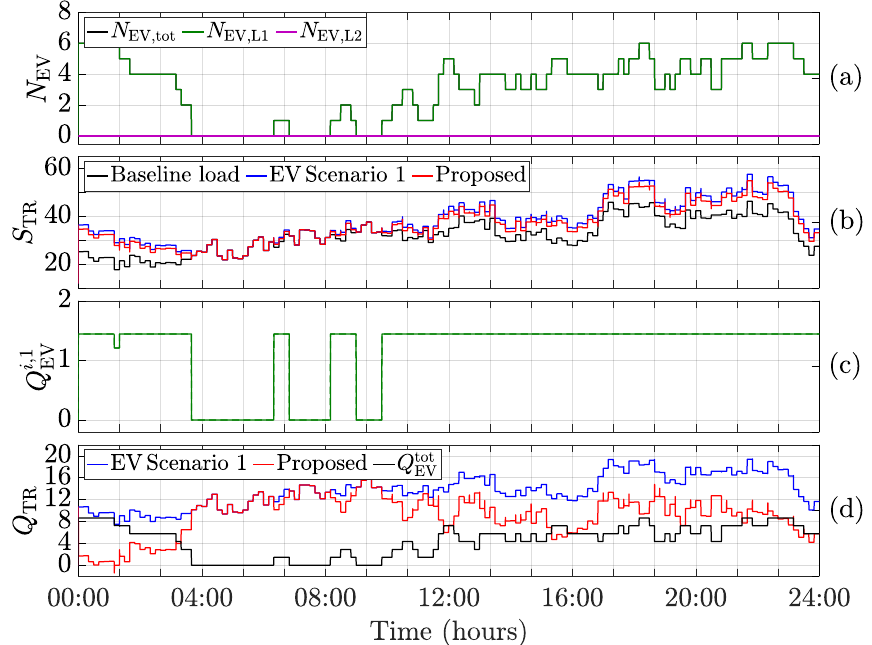
Figure 7. Scenario 1: EV charging at Level 1, ( a ) number of EVs present; ( b ) transformer apparent power in kVA; ( c ) Q supplied by an online EV at Level 1 in kVAr; ( d ) transformer reactive power in